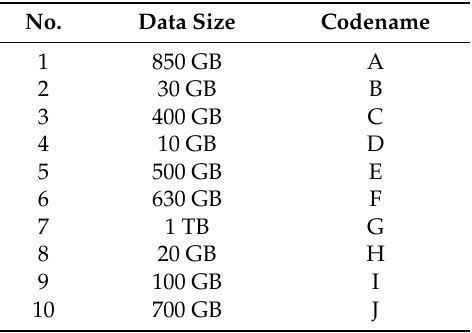
Table 6. Test data set.